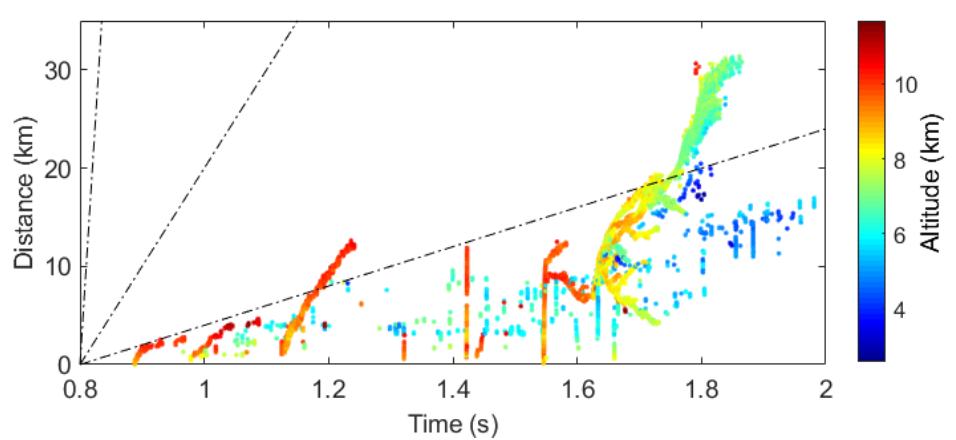
Figure 6. Time–distance graphs of sources of the IC flash. The solid line indicates the reference location for the distance, which is the initiation point of the IC flash. The sign of distance is consistent with the sign of the difference in height between the radiation source and the lightning initiation point. The dashed reference lines indicate slopes corresponding to speeds of 2 × 10 4 m/s, 1 × 10 5 m/s, and 1 × 10 6 m/s.